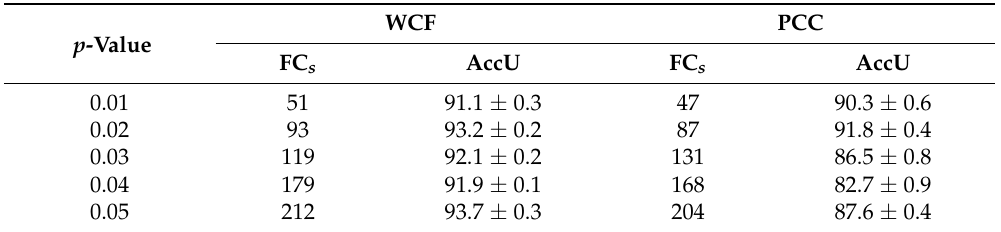
Table 3. Number of significant FC patterns of WCF and PCC based on classification accuracy (%) evaluated for 10-fold CV at different p -values (0.01–0.05) using ANOVA-SVM algorithm.